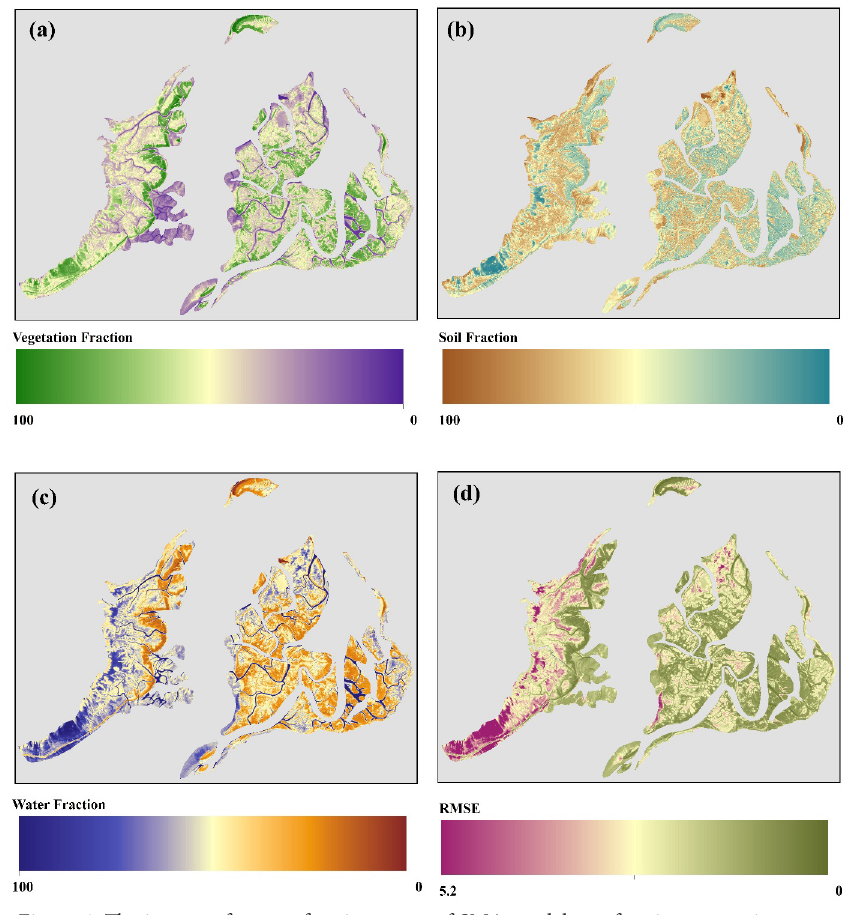
Figure 4. The images of output fraction cover of SMA model: a – fraction vegetation cover; b – fraction Soil; c – fraction Water; d – RMSE level of the model